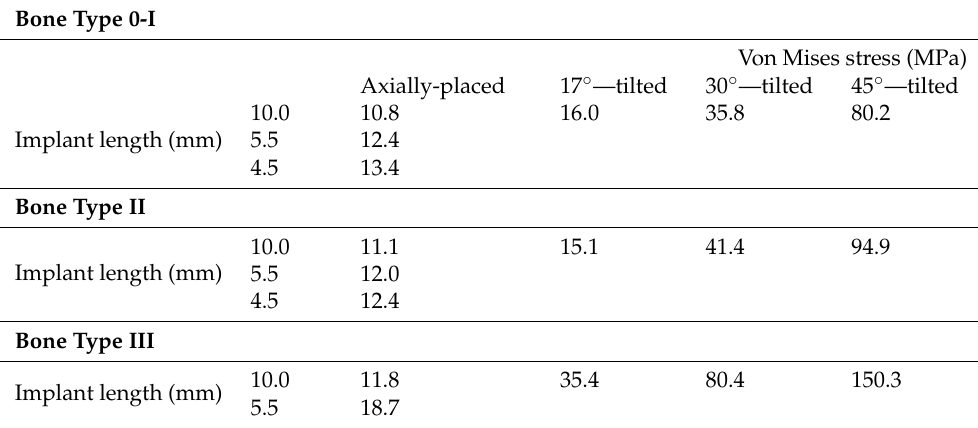
Table 2. Von Mises stresses (MPa) in bone tissue around immediately-loaded implants. Axial load was 200 N.